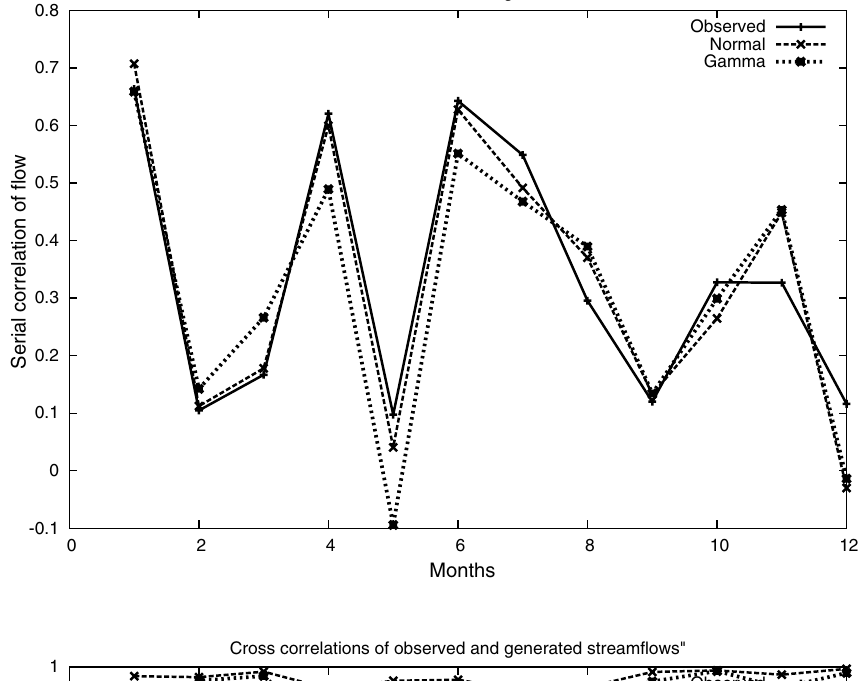
Fig. 10 Historical and generated monthly cross-correlations of flows in Konar and Barakar (single-site